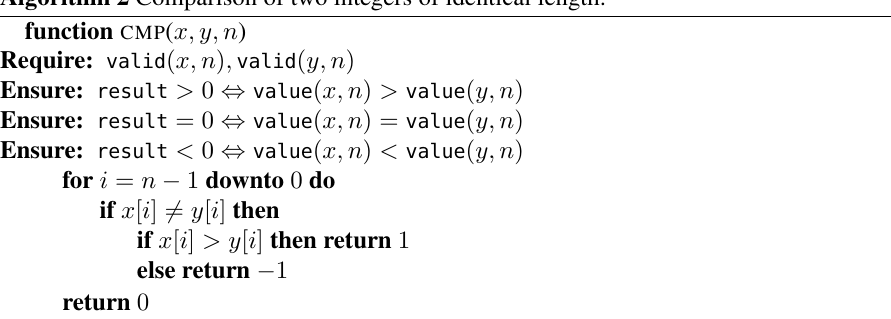
Algorithm 2 Comparison of two integers of identical